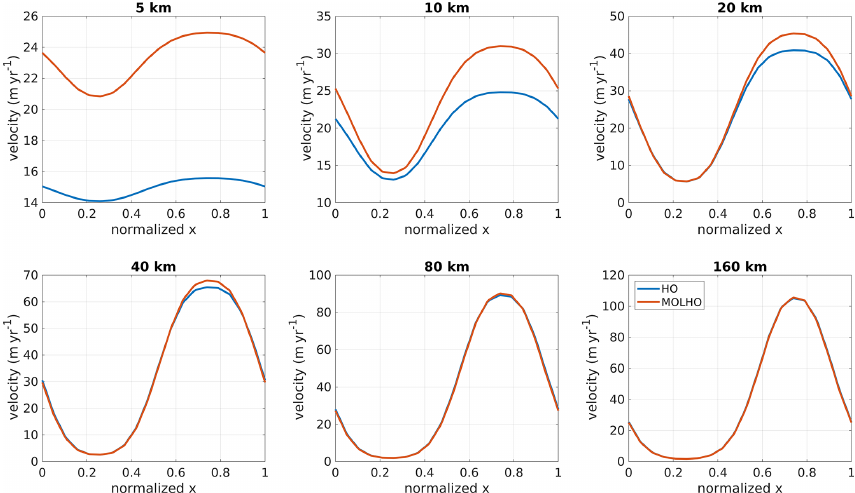
Figure 1. ISMIP-HOM experiment A: surface velocity at y = 0 . 25 L for different wavelengths, L , obtained with the three-dimensional higher-order model (HO) and with the two-dimensional MOno-Layer Higher-Order (MOLHO) model. The surface velocity is computed by (cid:113) v 2 x + v 2 y ). We employ 20 vertical layers for the HO model. taking the Euclidean norm of the horizontal velocities at the ice surface (i.e.,